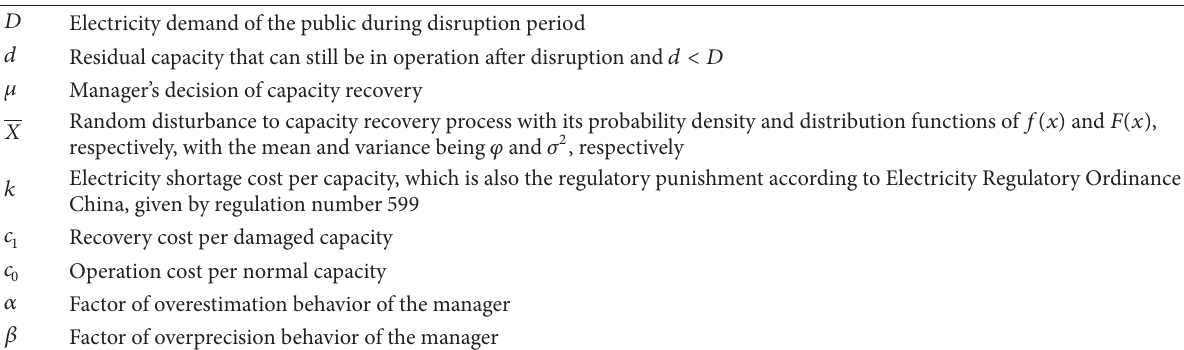
Table 1: Notation descriptions in the proposed